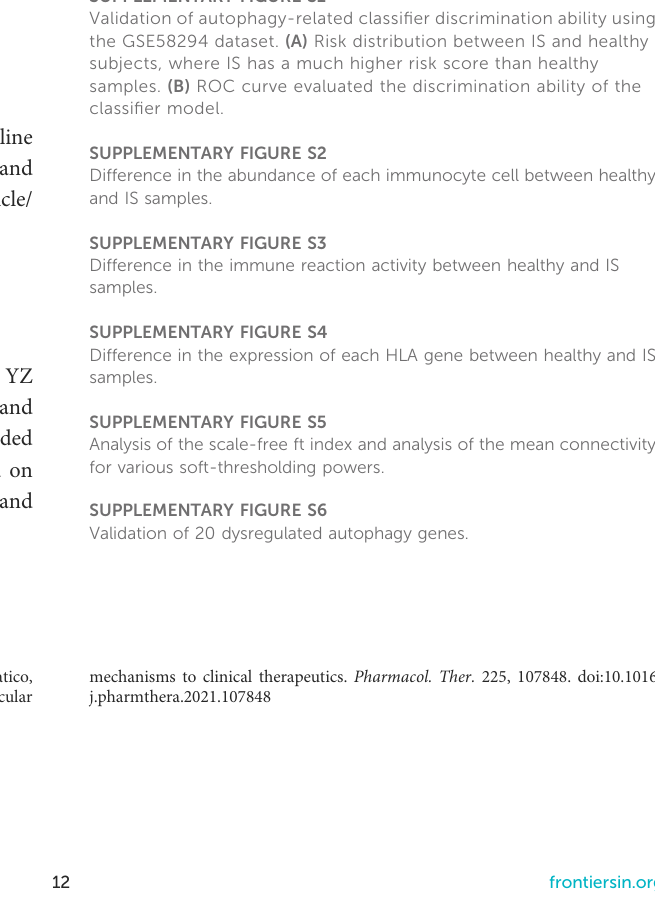
SUPPLEMENTARY FIGURE S1 Validation of autophagy-related classi fi er discrimination ability using the GSE58294 dataset. (A) Risk distribution between IS and healthy subjects, where IS has a much higher risk score than healthy samples. (B) ROC curve evaluated the discrimination ability of the classi fi er model. SUPPLEMENTARY FIGURE S2 Difference in the abundance of each immunocyte cell between healthy and IS samples. SUPPLEMENTARY FIGURE S3 Difference in the immune reaction activity between healthy and IS samples. SUPPLEMENTARY FIGURE S4 Difference in the expression of each HLA gene between healthy and IS samples. SUPPLEMENTARY FIGURE S5 Analysis of the scale-free ft index and analysis of the mean connectivity for various soft-thresholding powers. SUPPLEMENTARY FIGURE S6 Validation of 20 dysregulated autophagy